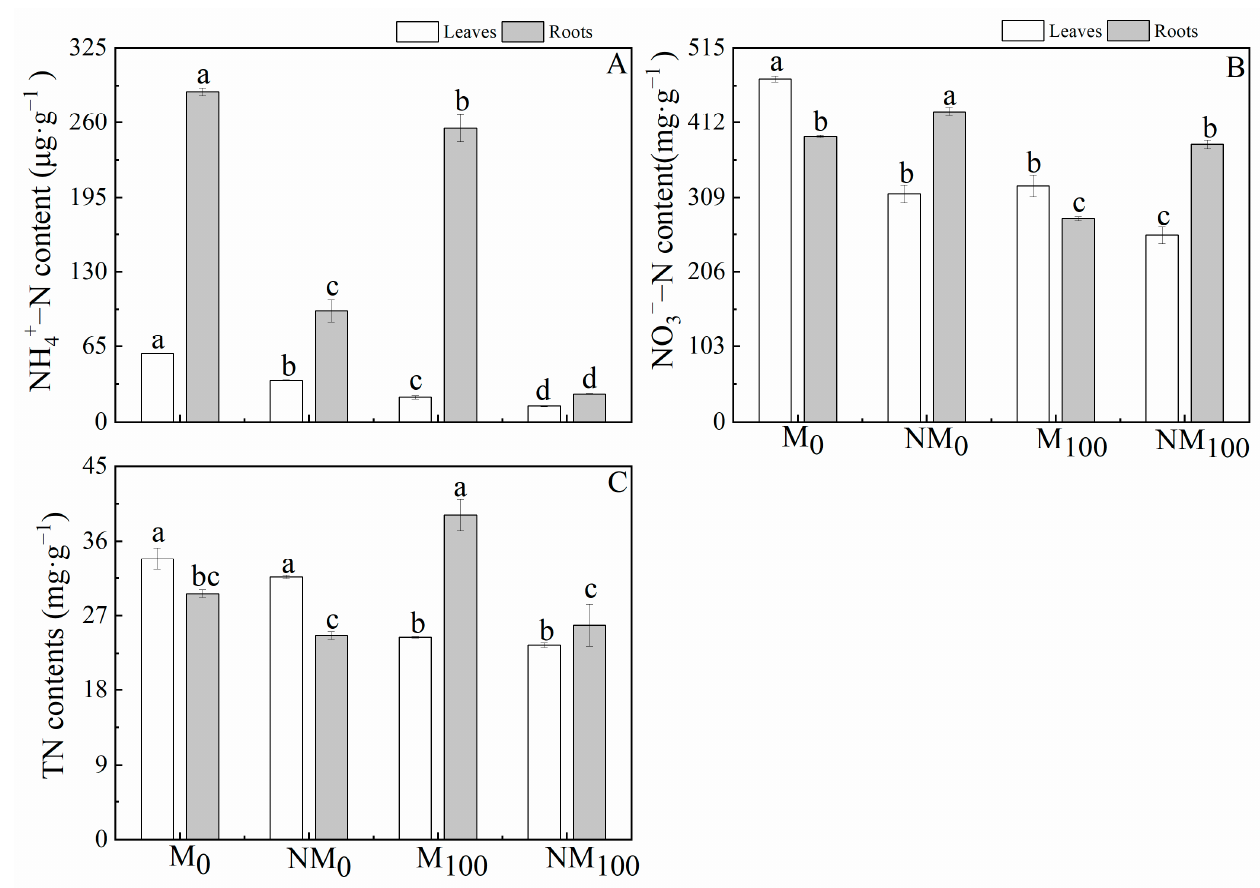
Figure 3. Changes in the contents of ammonium nitrogen (NH 4+ –N, ( A )), nitrate nitrogen (NO 3 − –N, ( B )), and total nitrogen (TN, ( C )) in leaves and roots of Neva irrigated with or without magnetized water following exposure to 0 or 100 µ mol · L − 1 cadmium stress. Values are the means ± SE of at least three replicates. Different lowercase letters indicate significant differences among the four treatments at the 0.05 level in leaves ad